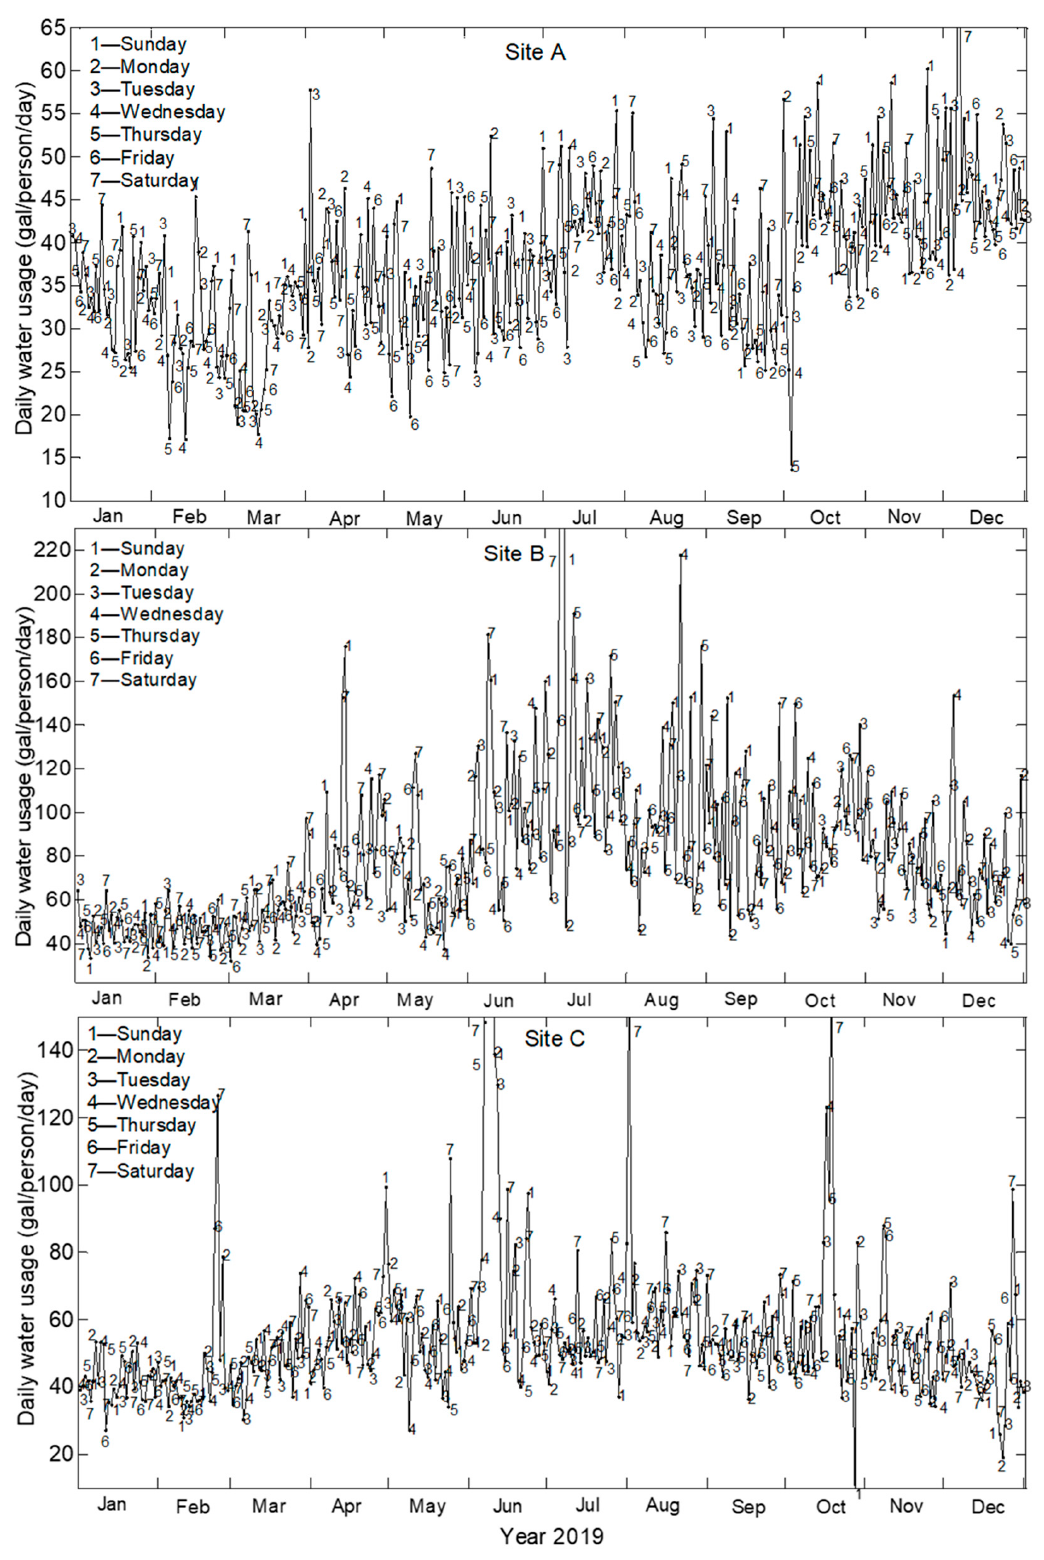
Figure 2. Daily water use (gal/person/day) for the three study communities for the year 2019. Each data point is labeled 1–7 to designate the day of the week starting with Sunday being day 1. Very High daily water use was encountered primarily on Saturday and Sunday of each week. (Characteristics of the three communities, A – C are provided in Table 1) .